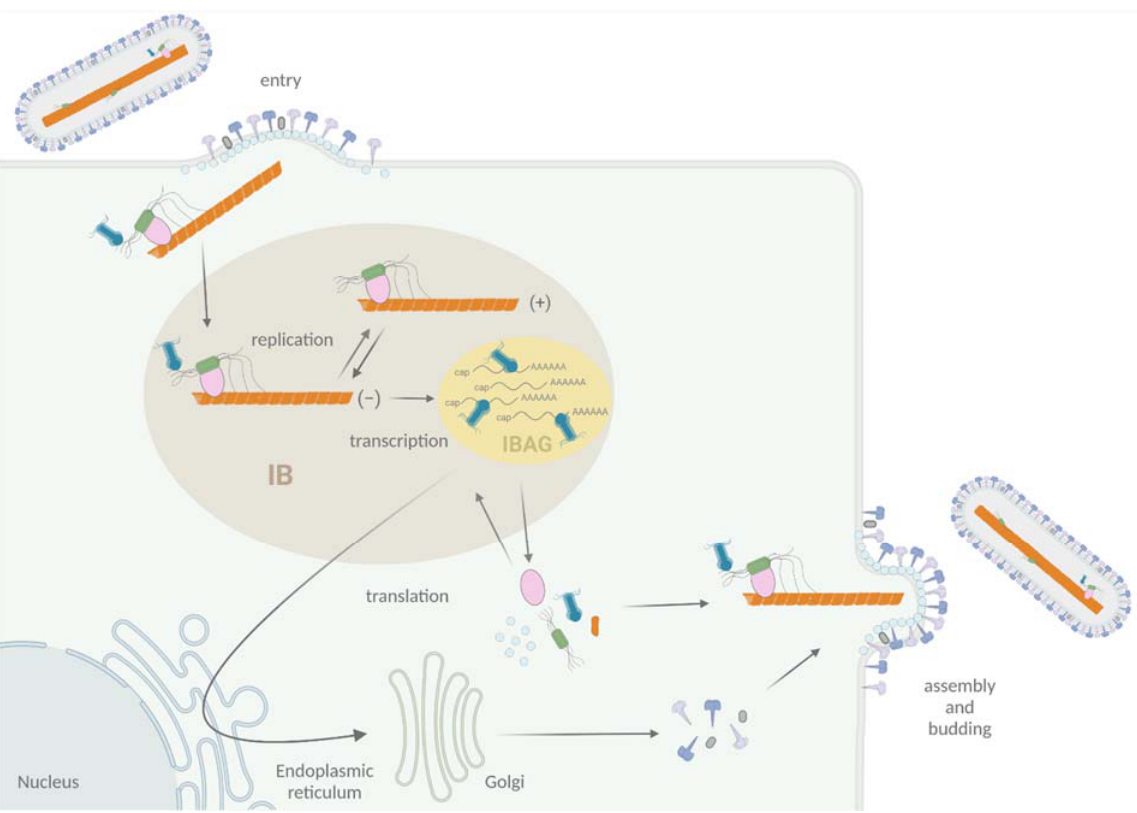
Figure 2. Schematic representation of the viral cycle of Pneumoviruses. Virion attachment to the cell is mediated by F and G proteins. The F protein is responsible for the fusion of viral and cell membranes, leading to the delivery in the cytoplasm of the NC complexed with L, P, and M2 ‐ 1 proteins. Transcription and replication occur in membrane ‐ less organelles called cytoplasmic inclusions bodies (IBs, light brown). Within IBs, M2 ‐ 1 and viral mRNAs accumulate into sub ‐ structures called inclusion body ‐ associated granules (IBAGs, yellow). After viral protein production and genome replication, assembly and budding of new viral particles take place at the plasma membrane. Adapted from “Replication Cycle”, by BioRender.com (2020). Retrieved from https://app.biorender.com/biorender ‐ templates (30 November 2021).